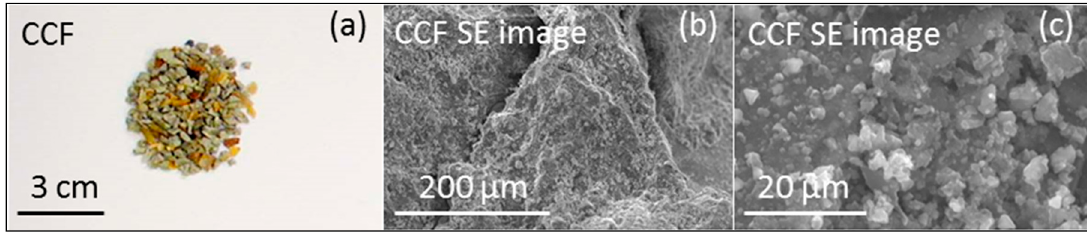
Figure 1. ( a ) Photograph of CCF, ( b,c ) secondary electron SEM images of the surface of CCF.